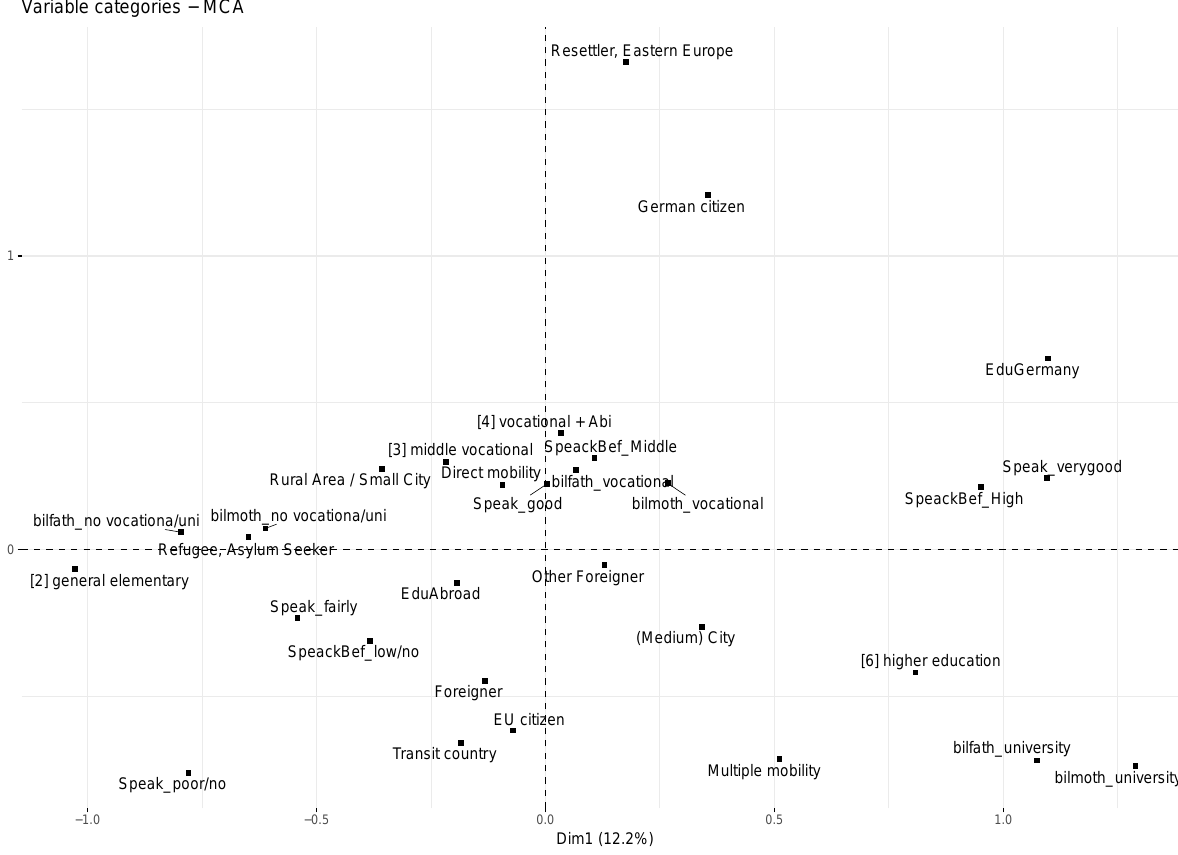
Figure 1. Variables’ modalities on the two-dimensional space identified through